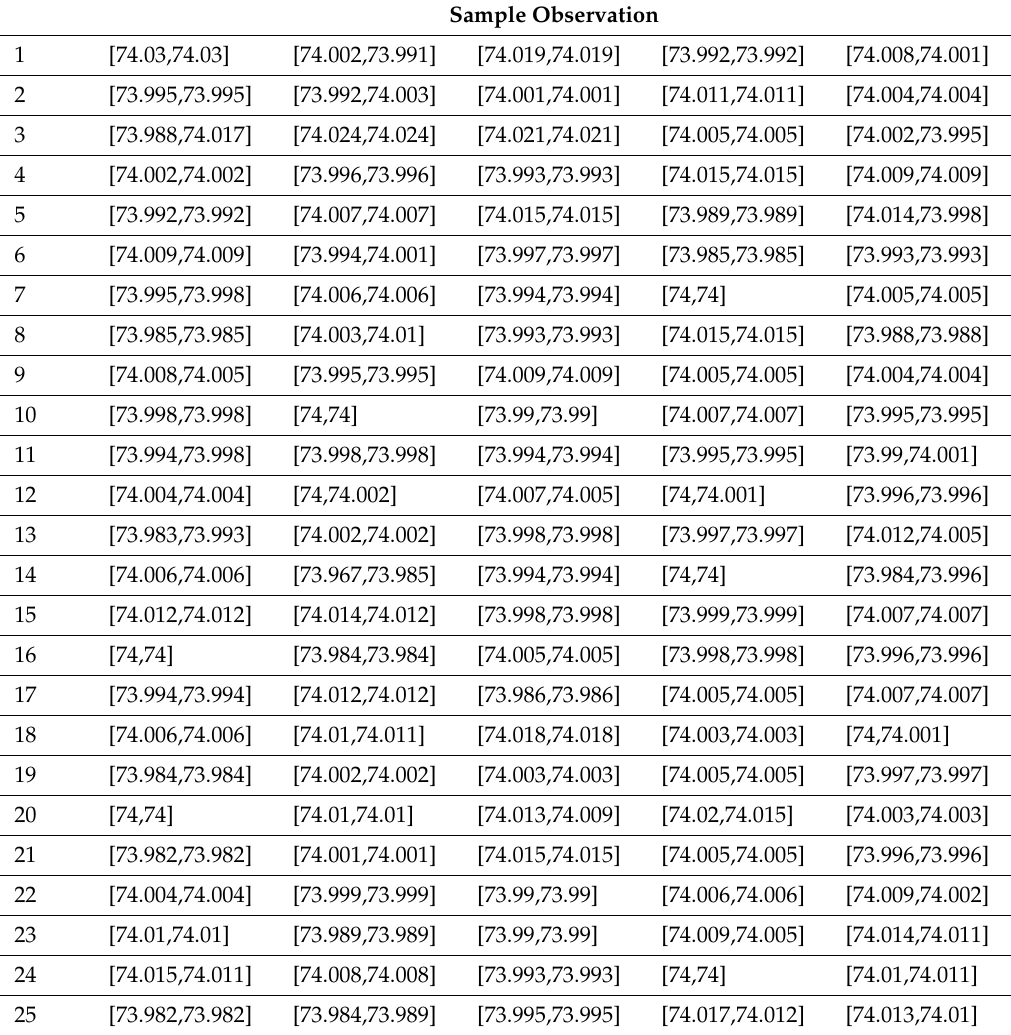
Table 9. Real example data taken from Reference